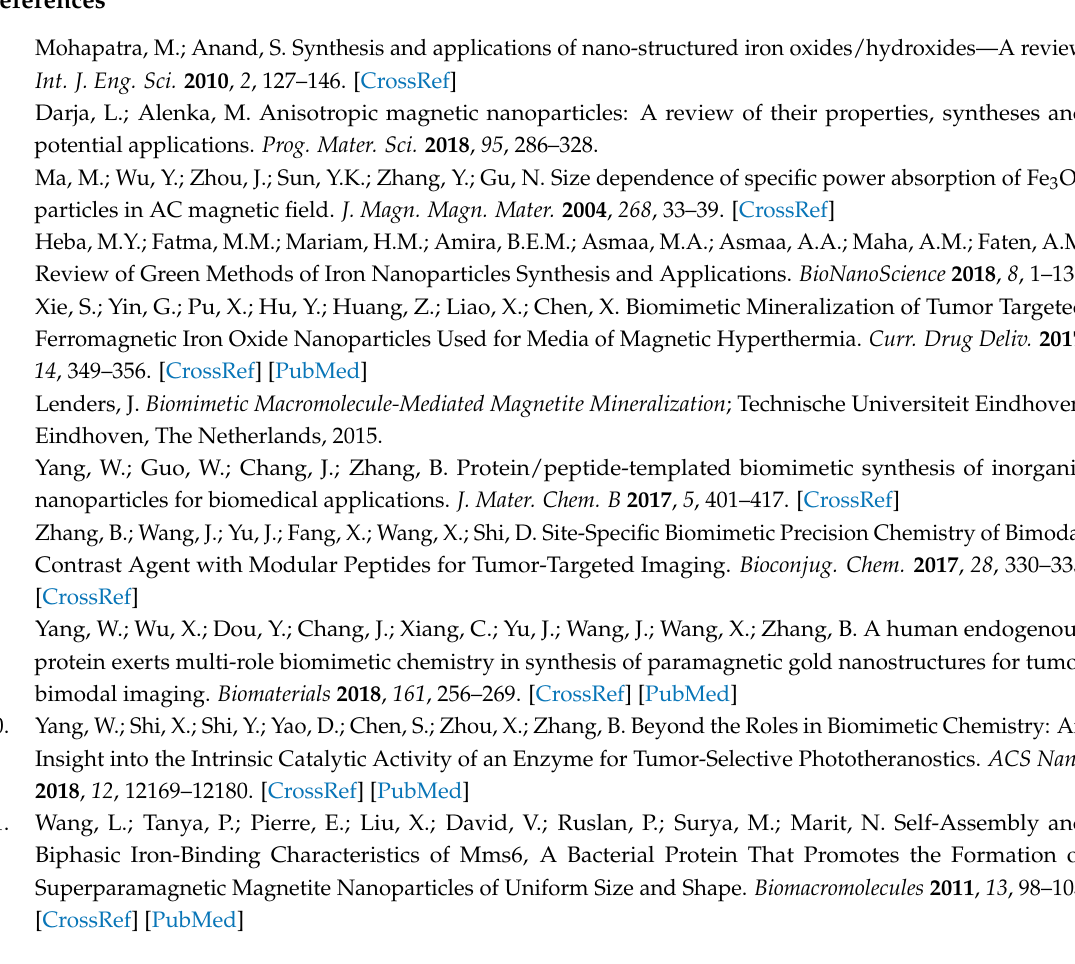
Supplementary Materials: Table S1: Side chain functional groups contained in 14-mer peptide. Figure S1: (a) XRD pattern of Fe 3 O 4 -TVN and Fe 3 O 4 -SVE nanoparticles, (b) TEM image of Fe 3 O 4 -TVN nanoparticles, (c) TEM image of